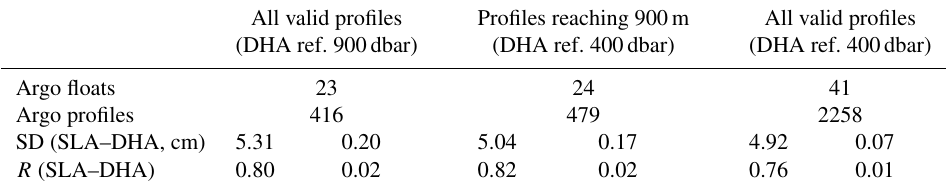
Table 1. Comparison of correlation and standard deviation (cm) of the differences between the new AVISO product for the Mediterranean Sea and Argo data referred to both 400 and 900dbar (sub-columns on the left). Sub-columns on the right display the results of the robustness experiments in terms of standard deviations (see text for details). DHA referred to 400dbar has been computed for all valid Argo profiles and those reaching 900m depth for comparison purposes. The number of Argo platforms and vertical profiles used are also